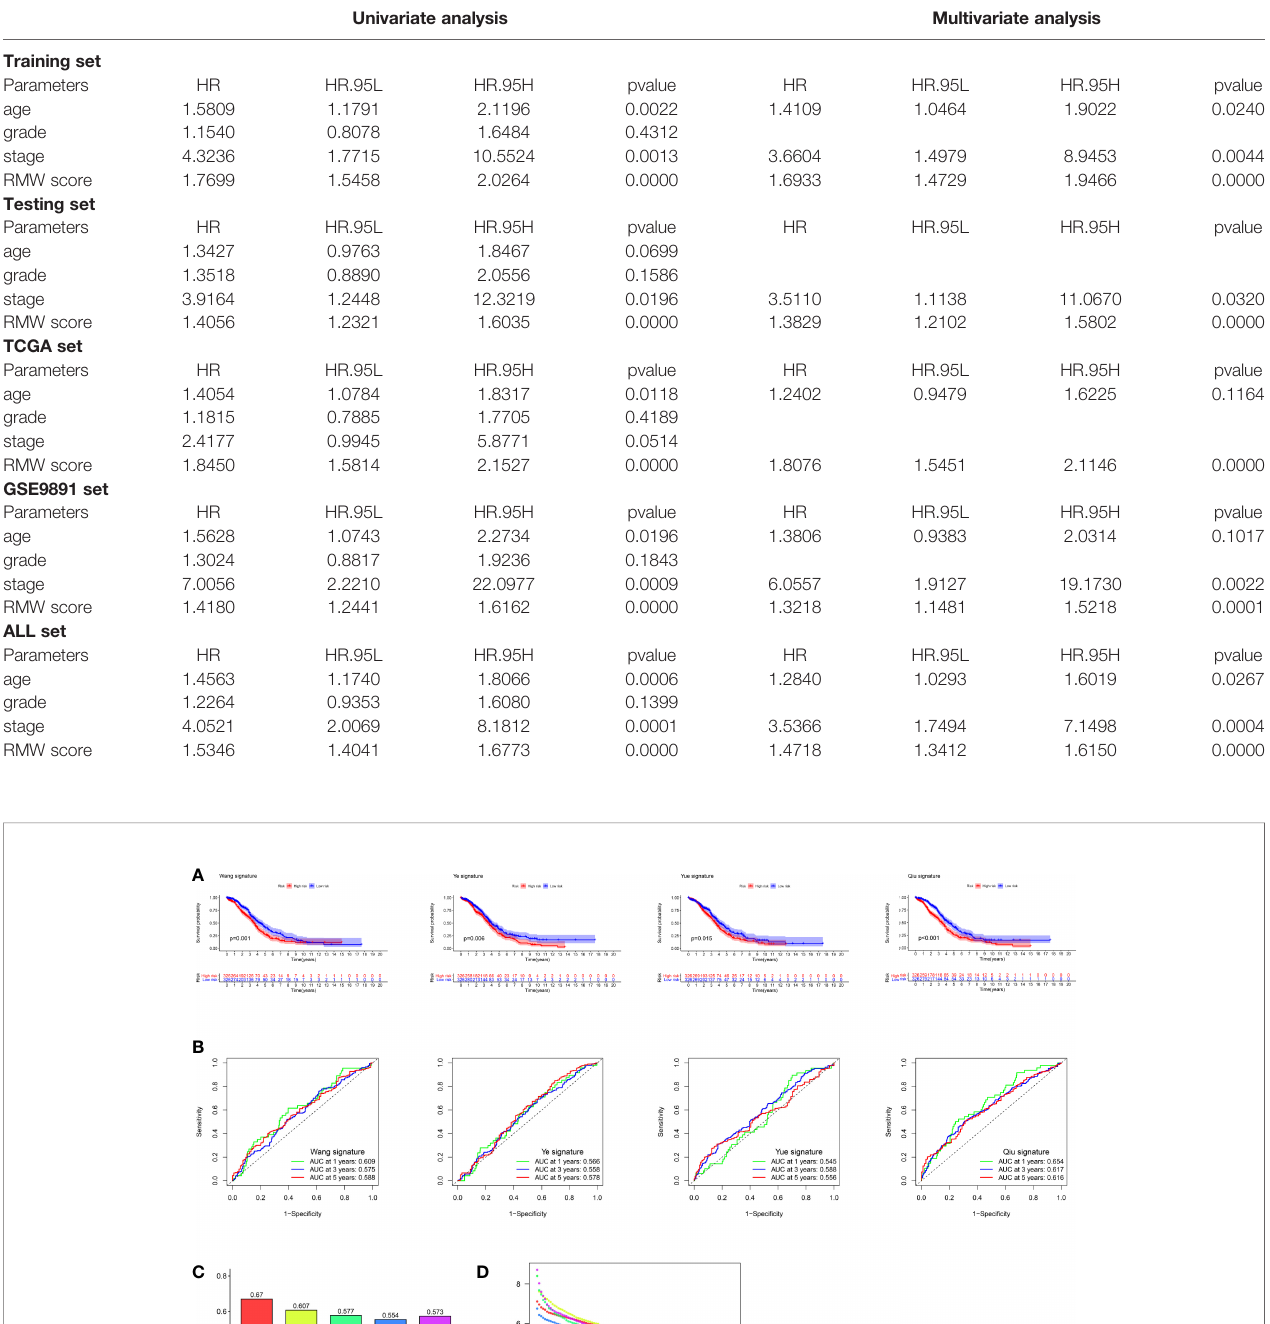
TABLE 1 | Univariate and multivariate Cox regression analysis of RMW score and clinical characteristics in fi ve cohorts. Univariate analysis